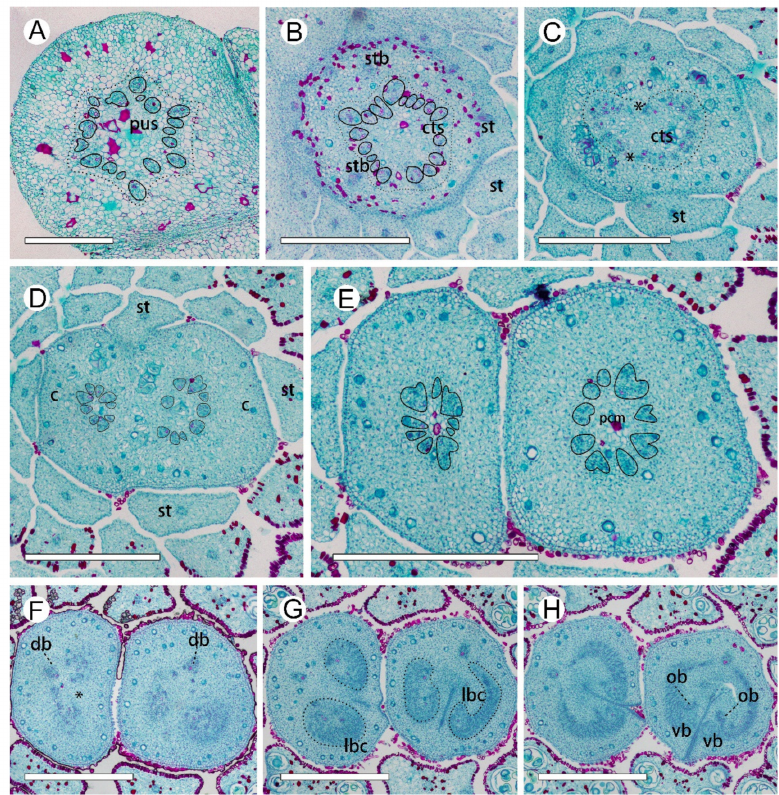
Figure 3. Ascending paraffin transections of Anaxagorea luzonensis flower. ( A ) Base of receptacle, showing the pseudostele (dotted line). ( B ) Mid-section of androecia, showing stamen bundles and central stele (dotted line). ( C ) Top of receptacle, showing central stele divided into two groups (* marked the breaks). ( D ) Bundles from the central stele enter carpels (each bundle is marked by a solid line). ( E ) Base of carpels, showing basal ring. ( F ) Upper part of carpel stipes, showing the basal ring breaks (marked as *). ( G ) Bottom of ovary locule, showing concentric lateral bundle complexes (left) and “C”-shaped lateral bundle complexes (right). ( H ) Base of ovary locule. Cts, central stele; db, dorsal bundle; lbc, lateral bundle complex; ob, ovule bundle; pcm, parenchyma; pus, pseudostele; st, stamen; stb, stamen bundle; vb, ventral bundle. Scale bars = 500 µ